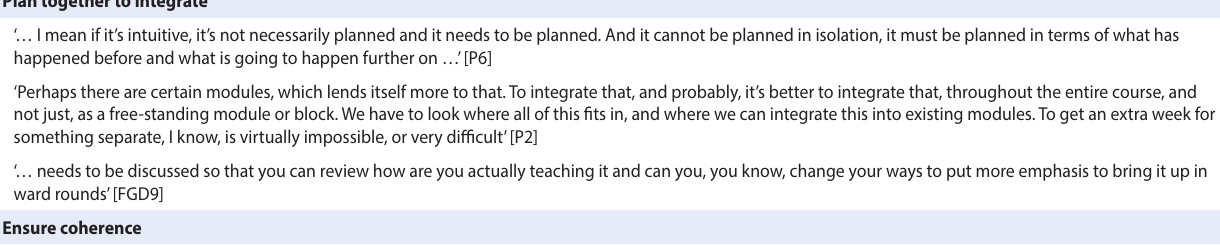
Table 4: Advice on how to strengthen teaching and learning of EBHC Plan together to